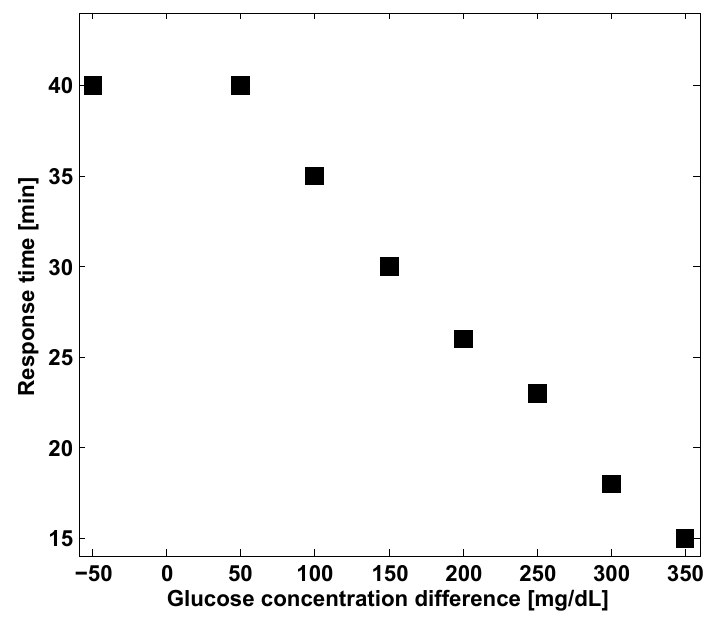
Figure 8. The response time of the glucose sensor for the concentration difference across the semi-permeable membrane.